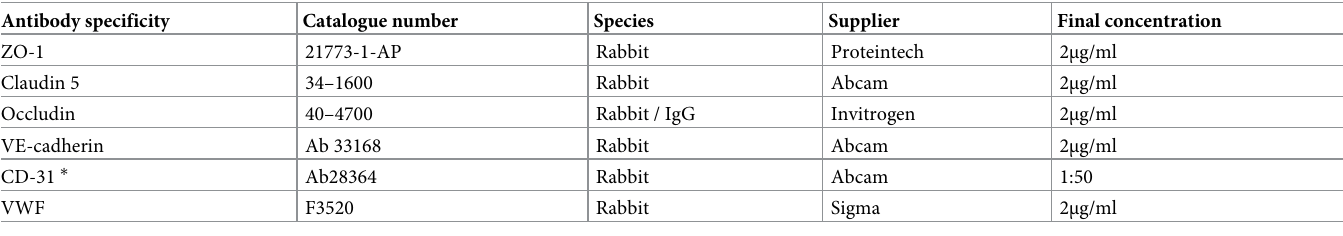
Table 1. Primary